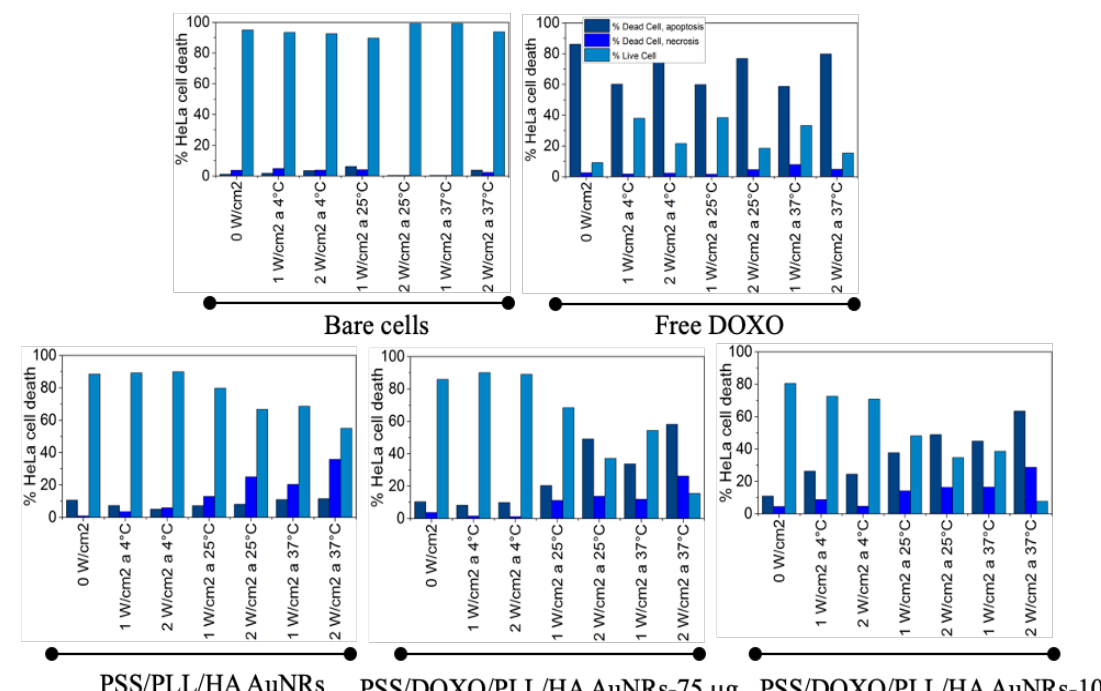
Figure 7. Main cell death mechanisms involved in cell mortality after administration of free DOXO, bare PSS/PLL/HA-coated and PSS/DOXO/PLL/HA-coated AuNRs with 75 and 100 µg DOXO for HeLa cells and at different temperatures and NIR fluencies.